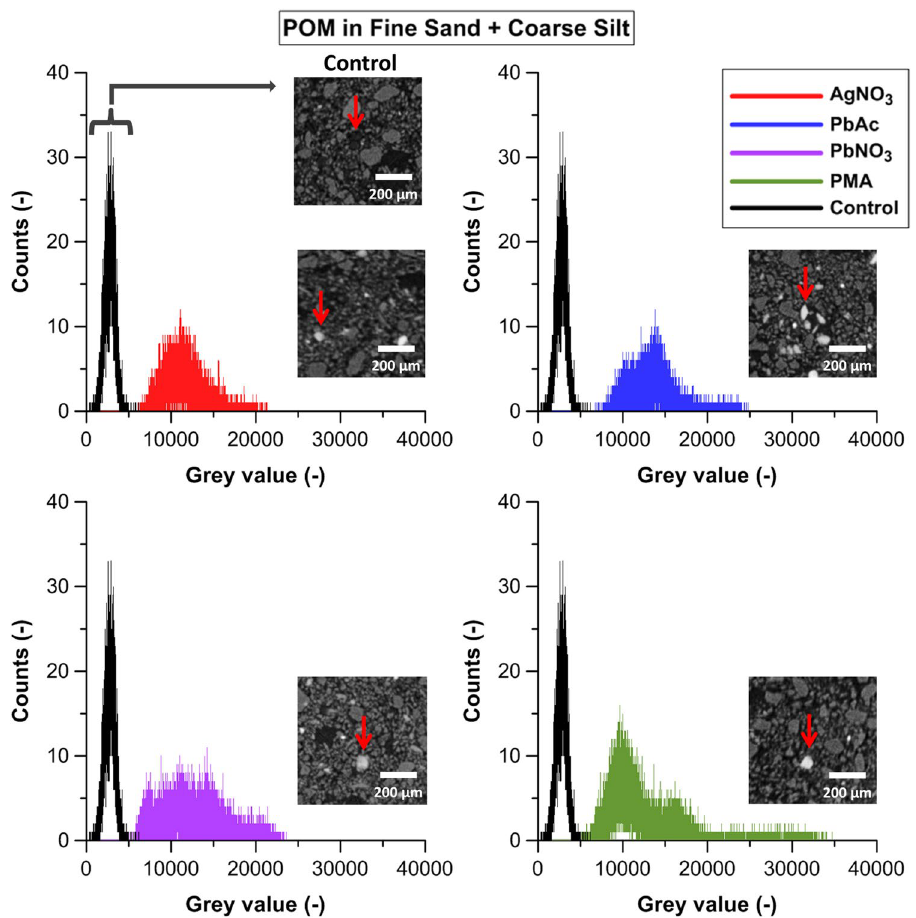
Figure 3. Grey scale histograms (0–40,000) of operator-supervised pin-pointed POM particles in 16 bit images of fine sand + coarse silt + POM mixtures: the unstained control treatment (black) and the stained AgNO 3 (red), PbAc (blue), Pb(NO 3 ) 2 (purple) and PMA (green) treatments. For each treatment, a two dimensional grey scale image representing a segment of a horizontal slice of the fine sand + coarse silt + POM mixtures is included (image contrast was enhanced in this figure). An unstained POM particle in the control treatment and stained POM particles in the AgNO 3 , PbAc, Pb(NO 3 ) 2 and PMA treatments are indicated by the red